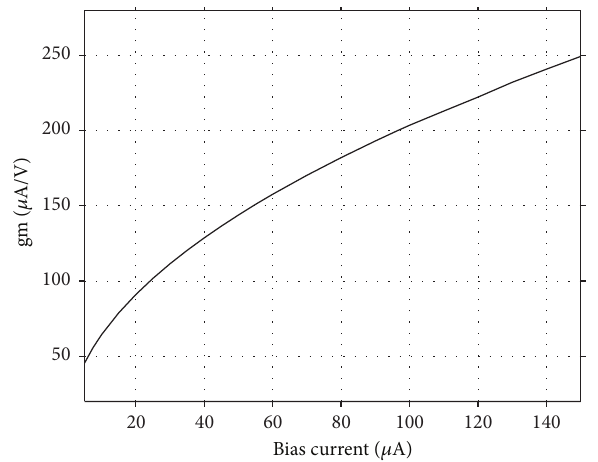
Figure 11: Variation of transconductance with bias current 𝐼 𝐵4 .